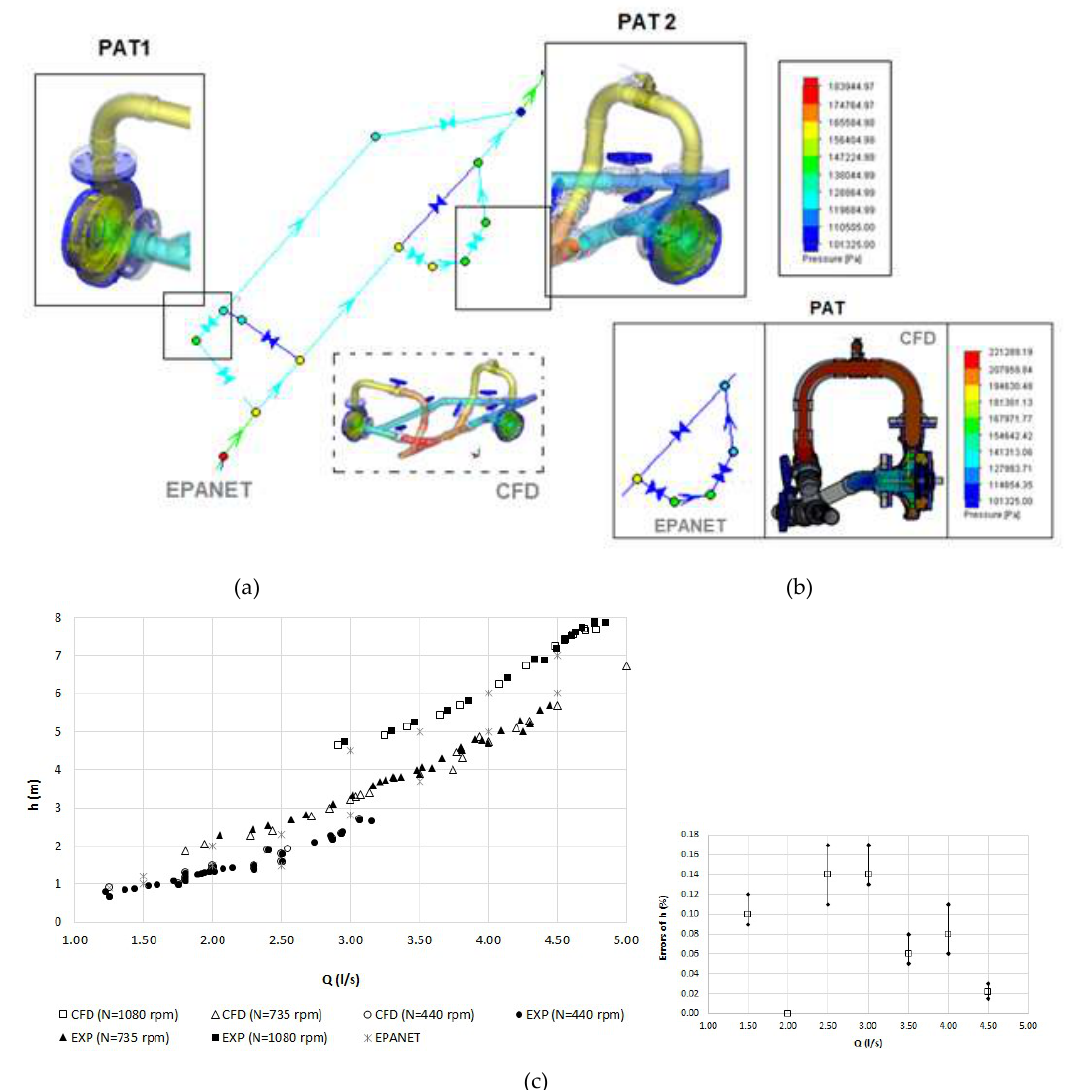
Figure 18. Head losses determined in parallel mode ( a ) and in single mode ( b ). Comparison between experimental results and modeling predictions with the associated errors ( c ).